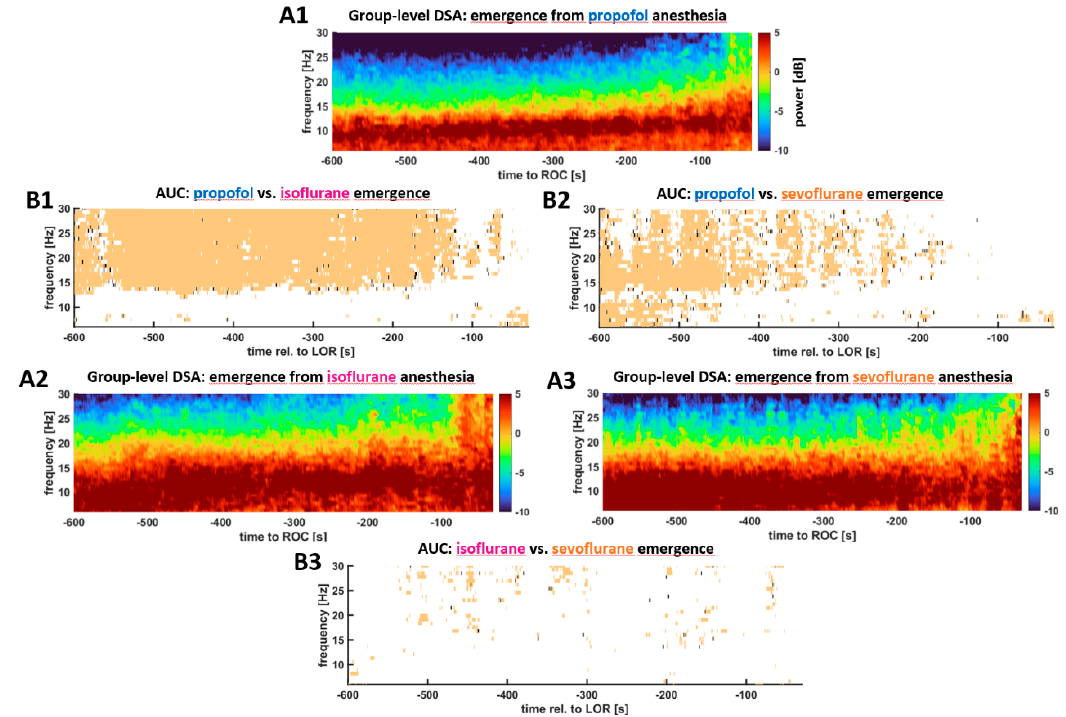
Figure 2. Density spectral arrays (DSA) plots for all three groups derived from the pooled (median) power spectral density of all patients within a group ( A ) and the corresponding information regarding a significant difference ( B ) as determined by the 95% confidence intervals of the AUC. A . DSA of anesthesia emergence for the different substance groups; A1 . Group-level emergence DSA of the patients receiving propofol. A2 . Group-level emergence DSA of the patients receiving isoflurane. A3 . Group-level emergence DSA of the patients receiving sevoflurane. B . Maps of the pixel-wise AUC calculations. B1 . Comparison between the propofol and isoflurane group. B2 . Comparison between the propofol and sevoflurane group. B3 . Comparison between the isoflurane and sevoflurane group. During emergence from propofol maintenance, the power in the frequencies above ~15 Hz was significantly lower than from maintenance with inhalational anesthetics ( B1 , B2 ). These differences persisted until very close to ROR when compared to the isoflurane group ( B2 ). There were no significant differences in the emergence behavior between sevoflurane and isoflurane ( B3 ).